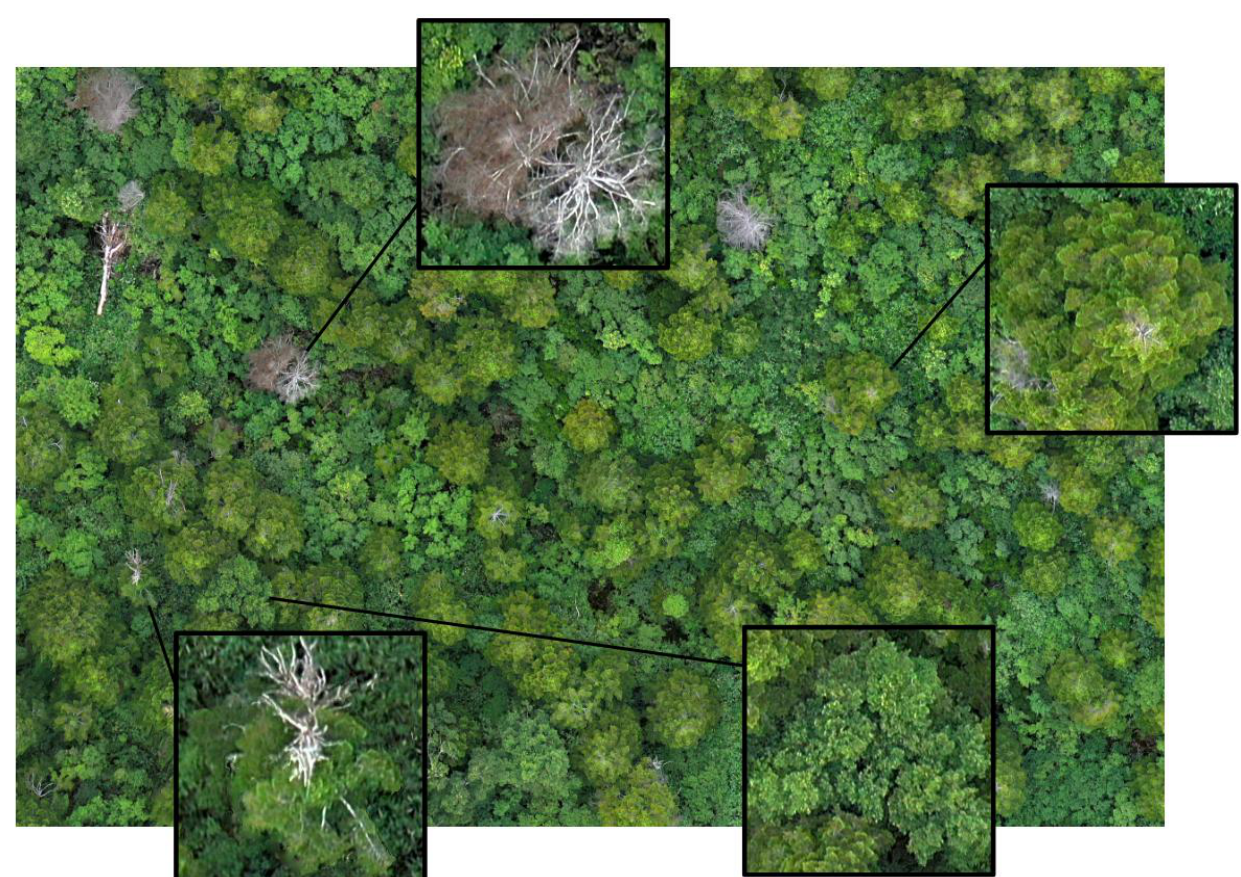
Figure 8. Example of the tree health Classification problem. Examples of each observed class is highlighted. In clockwise order from top, center: dead fir tree, healthy fir tree, deciduous tree, sick fir tree. The data depicted belongs to Zao mountain in Yamagata, Japan; see [63] for details. Regarding the “Data Issues” column, the following notation is used: “Wrong Split” (WS), “Late Split” (LS), “validation set for testing” (VST), “dependent test set” (DTS) or “insufficient information” (IINF), see Section 3 for